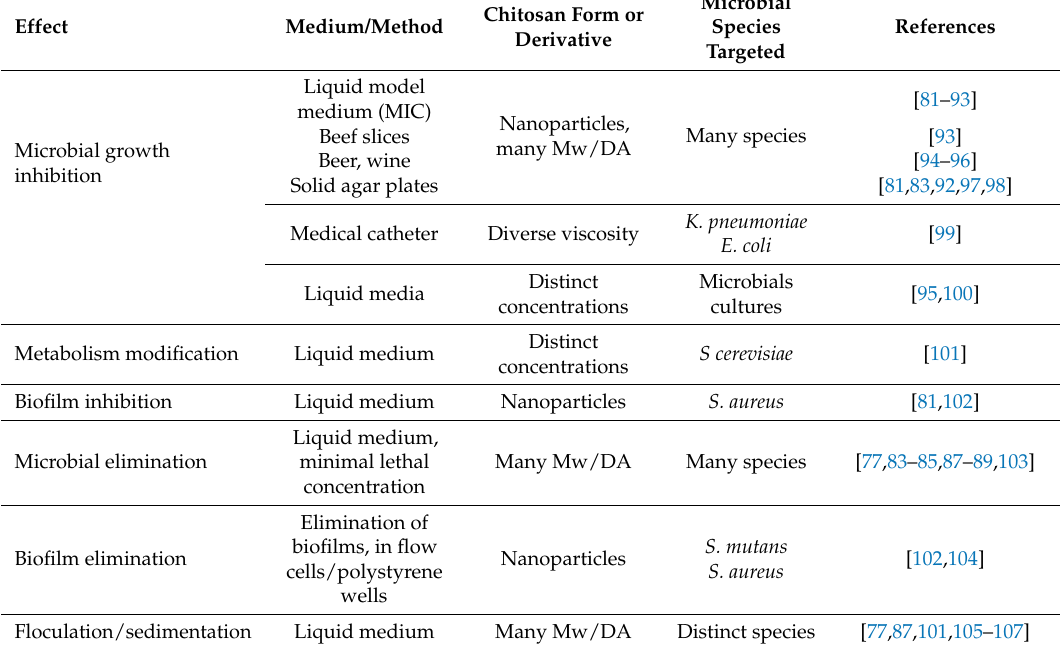
Table 2. Studies on antimicrobial activity of chitosan: diversity of target microbes, test media, and final aim of the